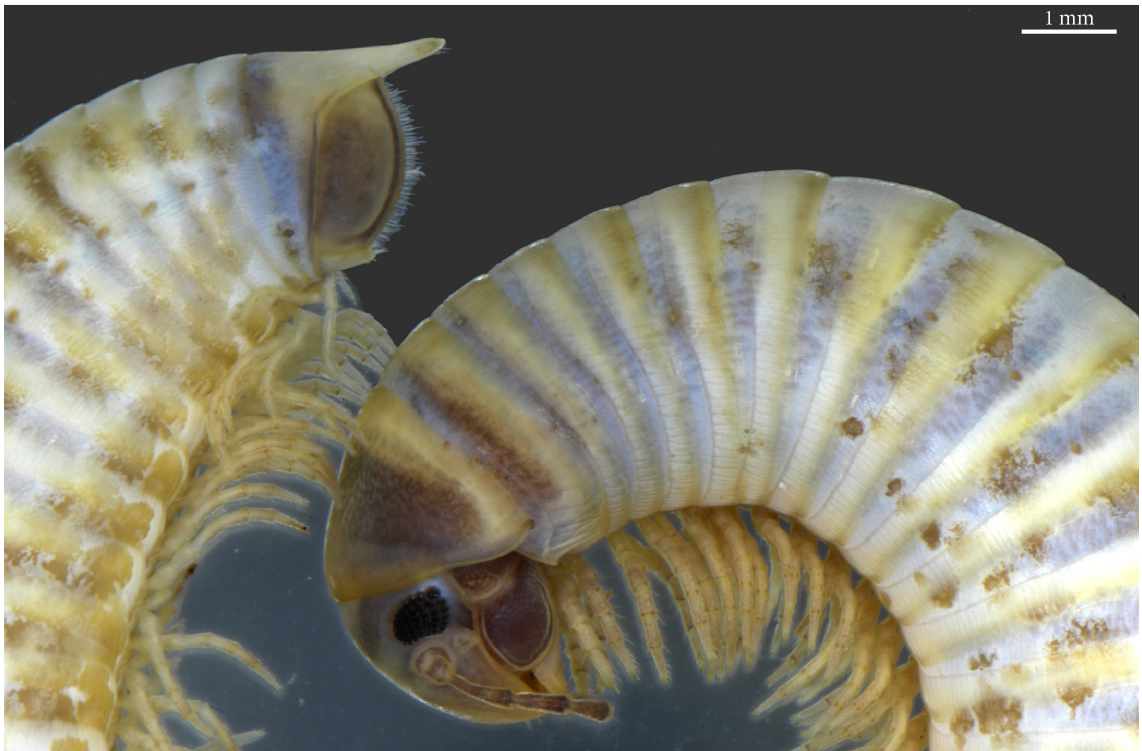
Fig. 1. Ommatoiulus alacygni sp. nov. Paratype ♀. habitus, lateral